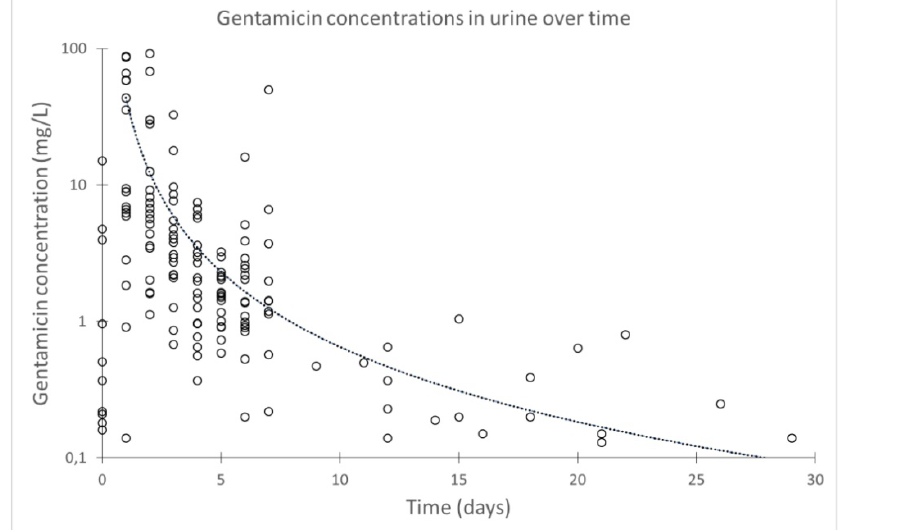
Figure 2: Gentamicin concentrations measured in urine. Every ○ represents one measurement. The dotted line represents the trend line.